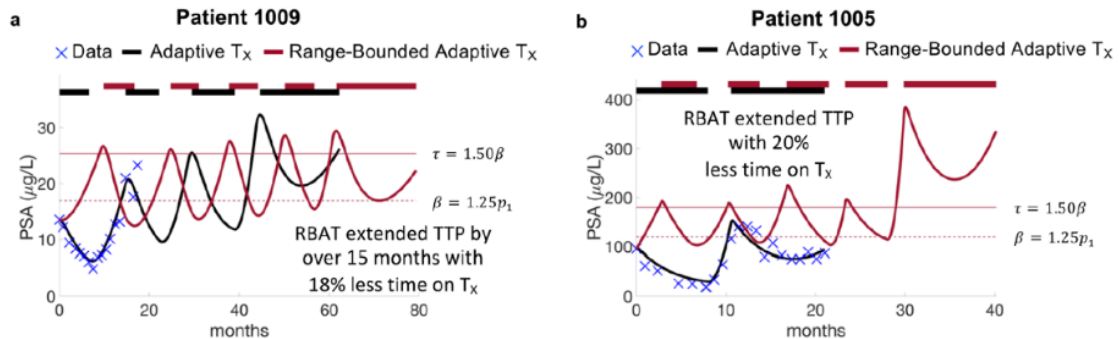
Figure 2. Model fits to adaptive therapy and simulations of range-bounded adaptive therapy. ( a ) Patient 1009 responded to adaptive until the end of the trial at 20 months. Model simulations forward showed that he would develop PSA progression after 60 months on adaptive therapy (black curve). Model simulations of range-bounded adaptive therapy show that time to progression can be extended by over 15 months with reduced cumulative dose. ( b ) Patient 1005 progressed on the trial after 20 months. Model simulations of RBAT extended time to progression to 40 months.